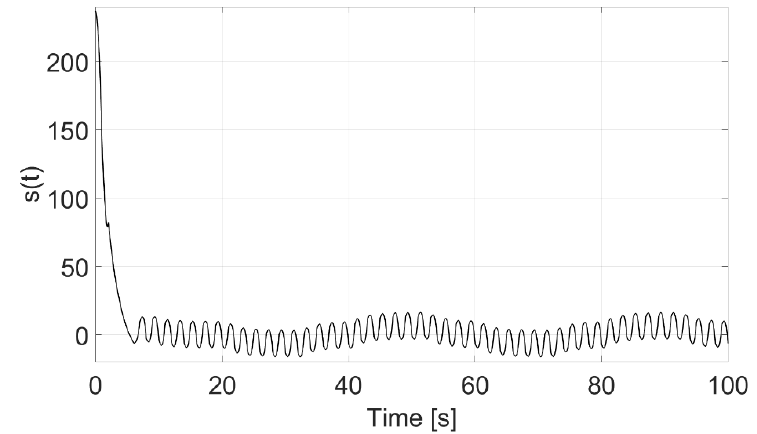
Figure 10. Sliding variable with the Gao’s reaching law controller.